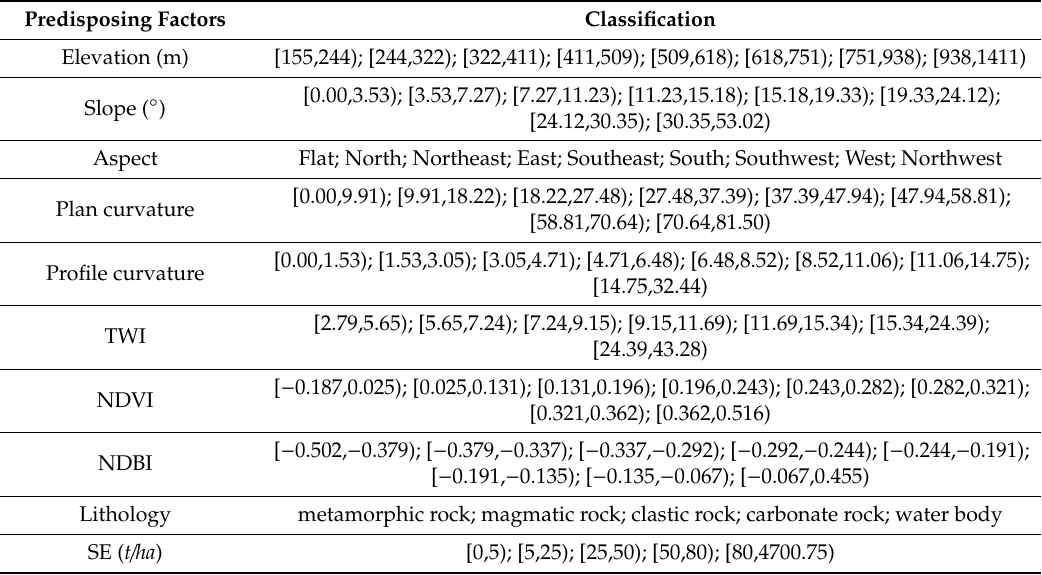
Table 1. Classifications of landslide predisposing factors with 30 m